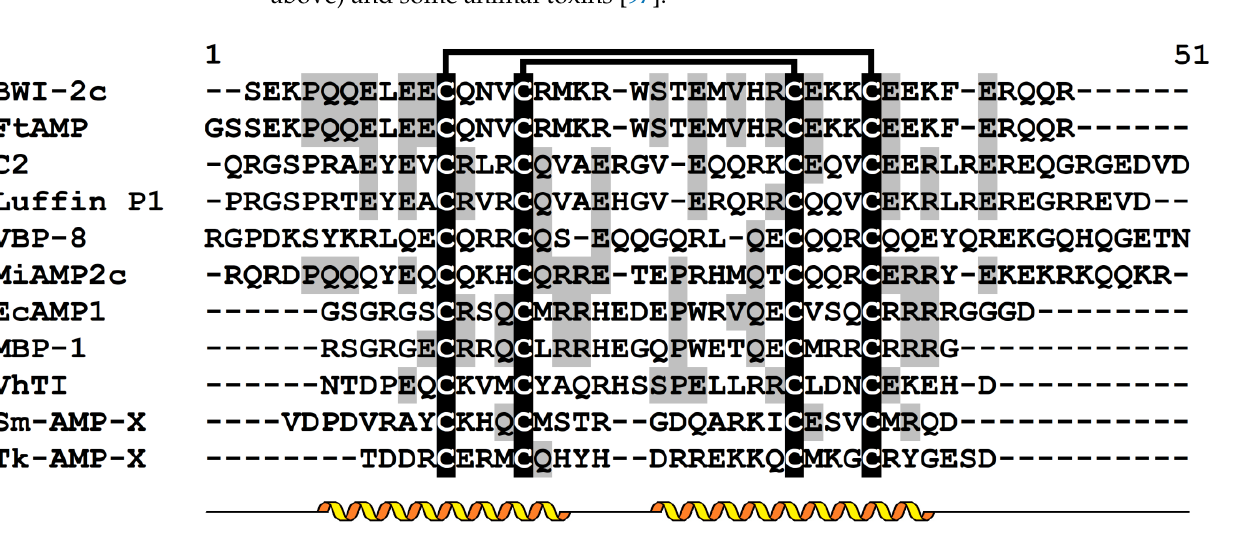
Figure 5. Multiple sequence alignment of α -hairpinins: BWI-2c (UniProt P86794) from Fagopyrum esculentum ; FtAMP from F. tataricum [94]; C2 (UniProt Q9ZWI3) from Cucurbita maxima ; luffin P1 (UniProt P56568) from Luffa aegyptiaca ; VBP-8 (PDB 6O3Q) from Solanum lycopersicum ; VhTI (UniProt P85981.1) from Veronica hederifolia ; MiAMP2c from Macadamia integrifolia [95]; EcAMP1 from Echinochloa crus-galli (PDB 2L2R); MBP-1 from Zea mays (UniProt P28794.1); Sm-AMP-X from Stellaria media (UniProt U4N938.1); and Tk-AMP-X from T. kiharae [96]. Cysteine residues are highlighted in white on the black background. Conserved amino acid residues are highlighted in black on the grey background. Lines above sequences denote disulfide bonds. Secondary structure elements (α - heliсеs) are shown for BWI -2c (PDB 2LQX) as helices under the alignment.